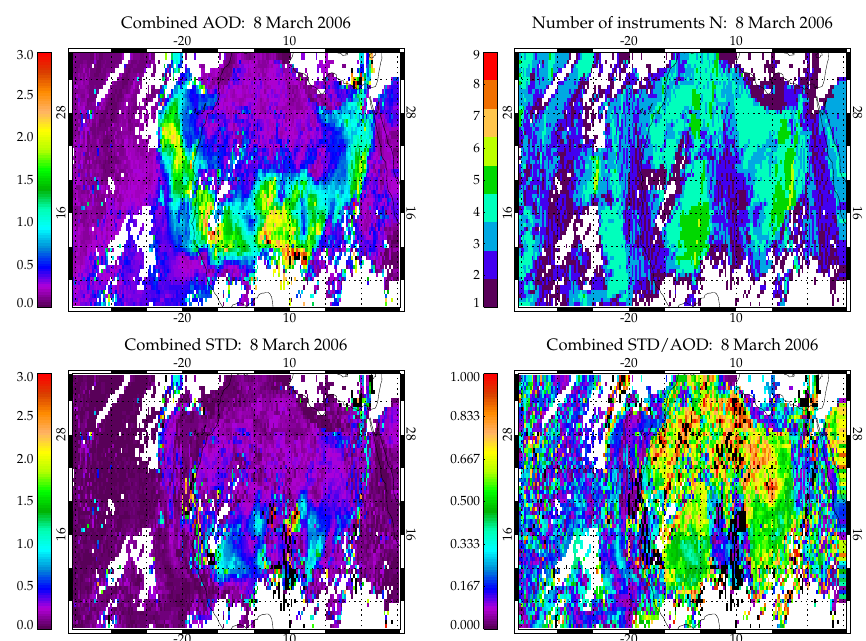
Fig. 13. Daily map for 8 March 2006 of the combined AOD (top left), the number N of instruments considered for every box (top right), standard deviation STD (bottom left) and ratio between standard deviation and aerosol optical depth STD/AOD (bottom right).